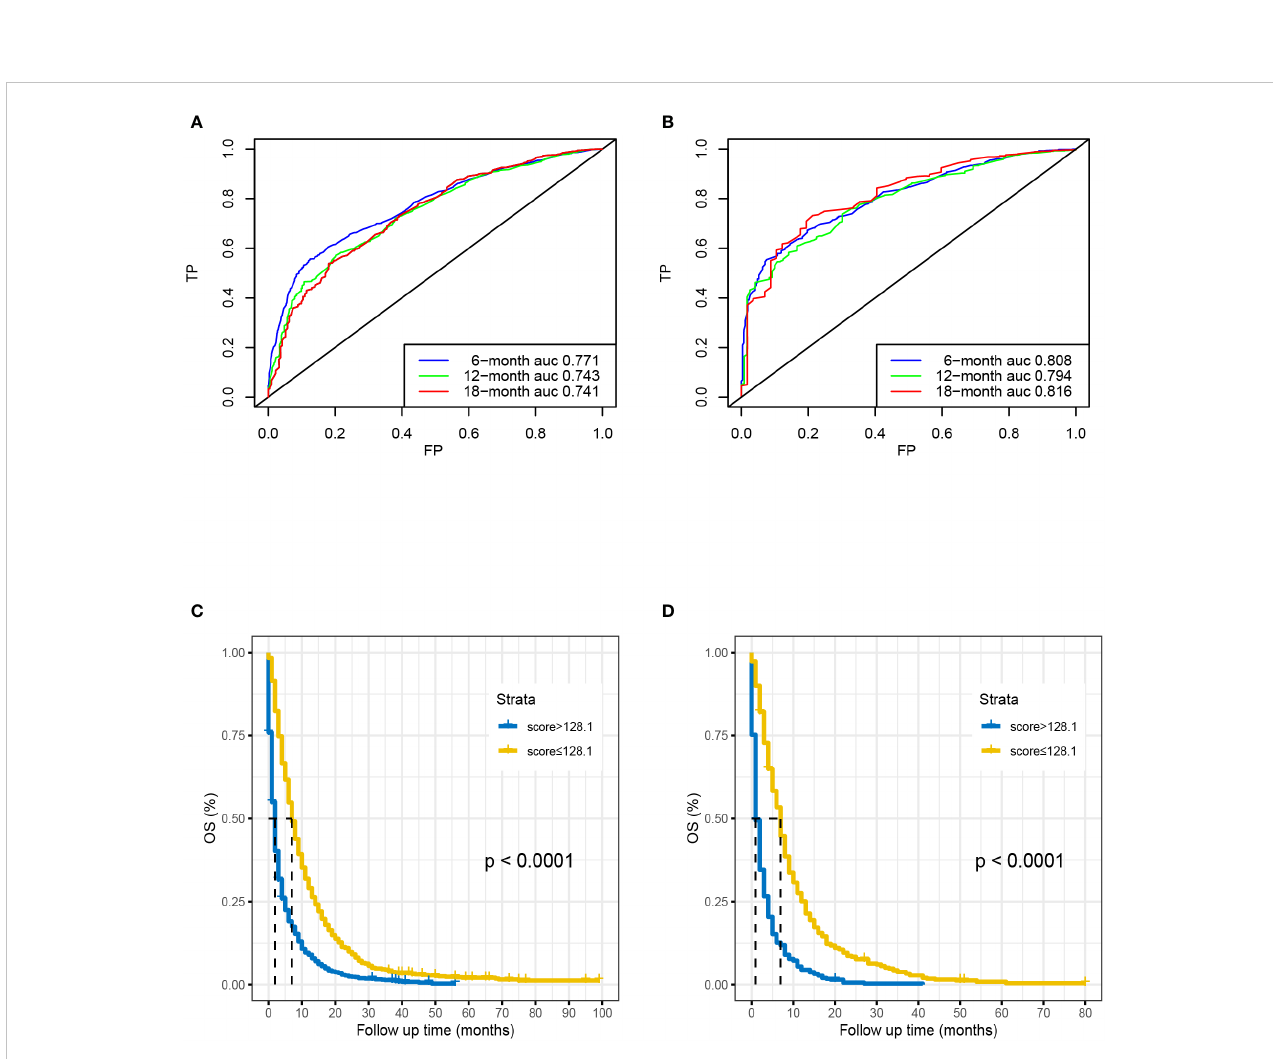
FIGURE 4 Time-dependent ROC curve analysis of the nomogram for the 6, 12, and 18 months in the training set (A) and the validation set (B) . The Kaplan – Meier survival curves of high-risk group and low-risk group in the training set (C) and in the validation set (D)